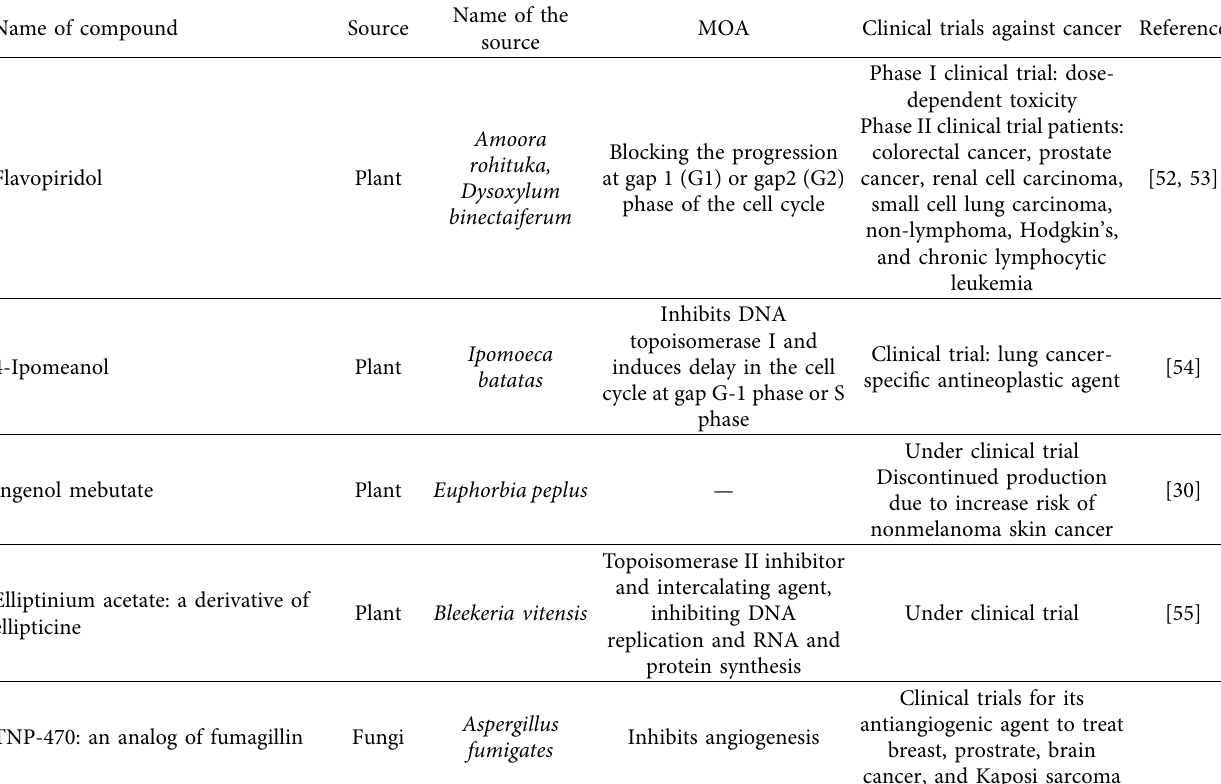
Table 2: Anticancer agent from natural sources that are under various stages of Clinical